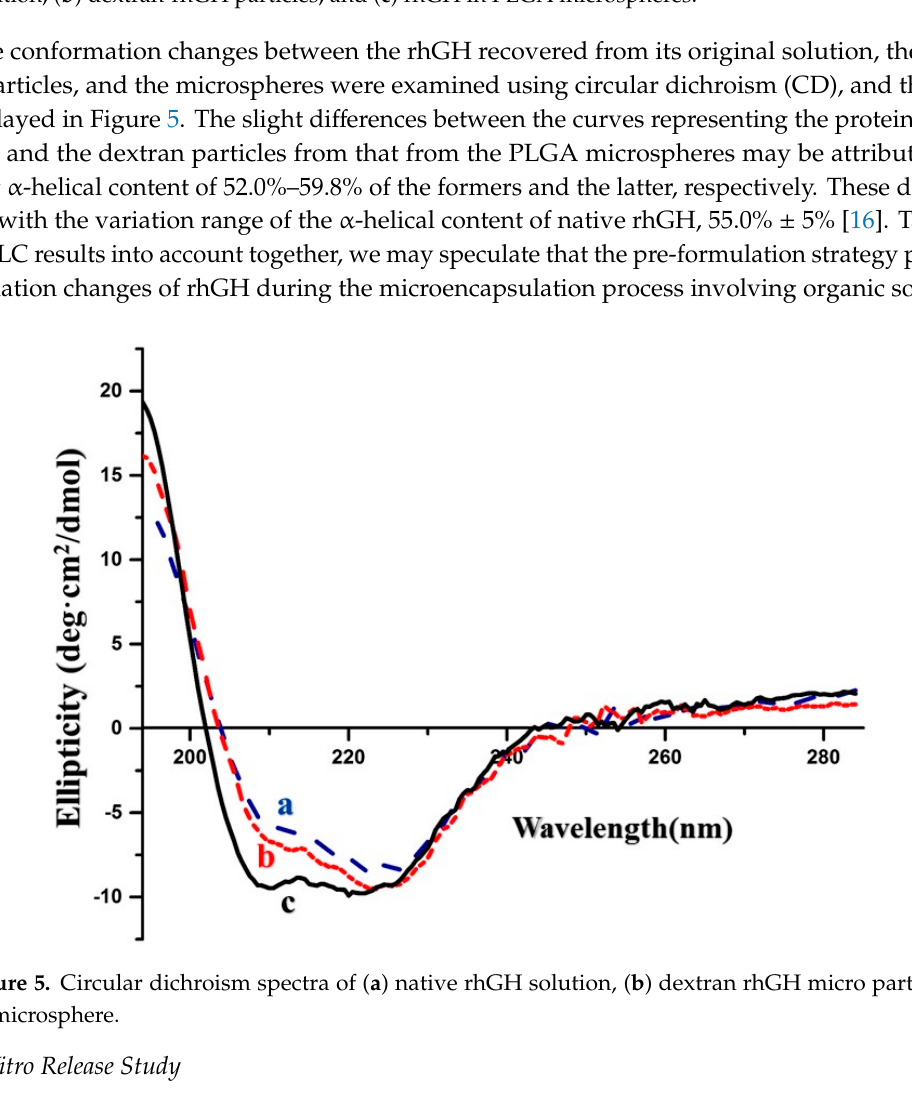
Figure 4. Size-exclusive high performance chromatography (SEC-HPLC) charts of ( a ) original rhGH solution, ( b ) dextran-rhGH particles, and ( c ) rhGH in PLGA microspheres.